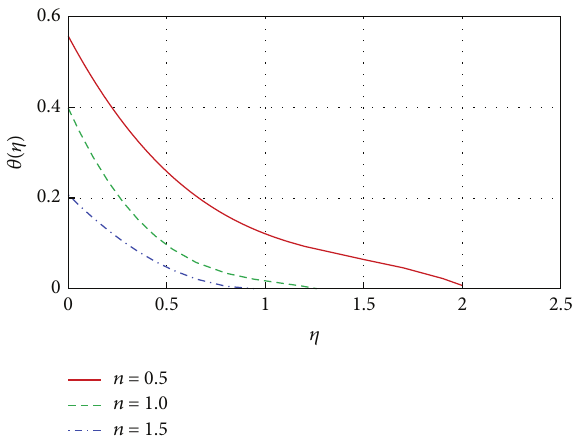
Figure 5: Temperature of non-Newtonian fluid at the vicinity of stretching sheet for constant values of Pr = 5